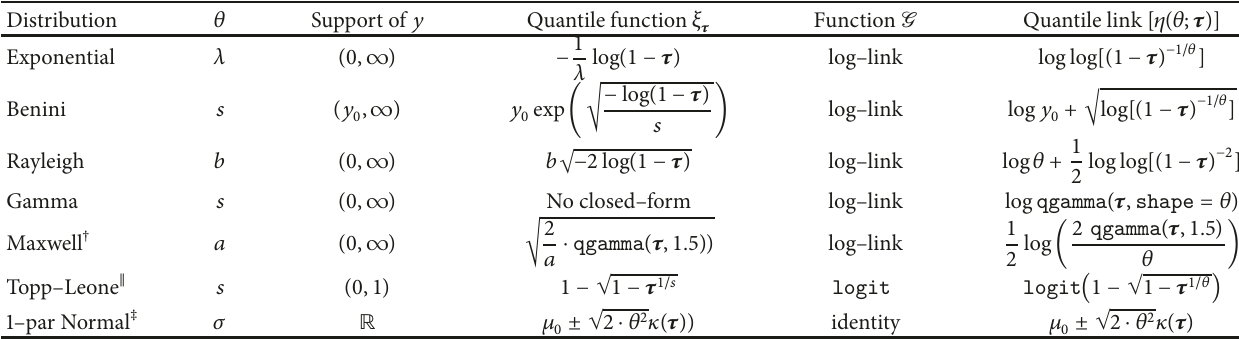
Table 2: New link functions for the quantiles of some 1–parameter distributions. The selected G function is also shown. Distribution